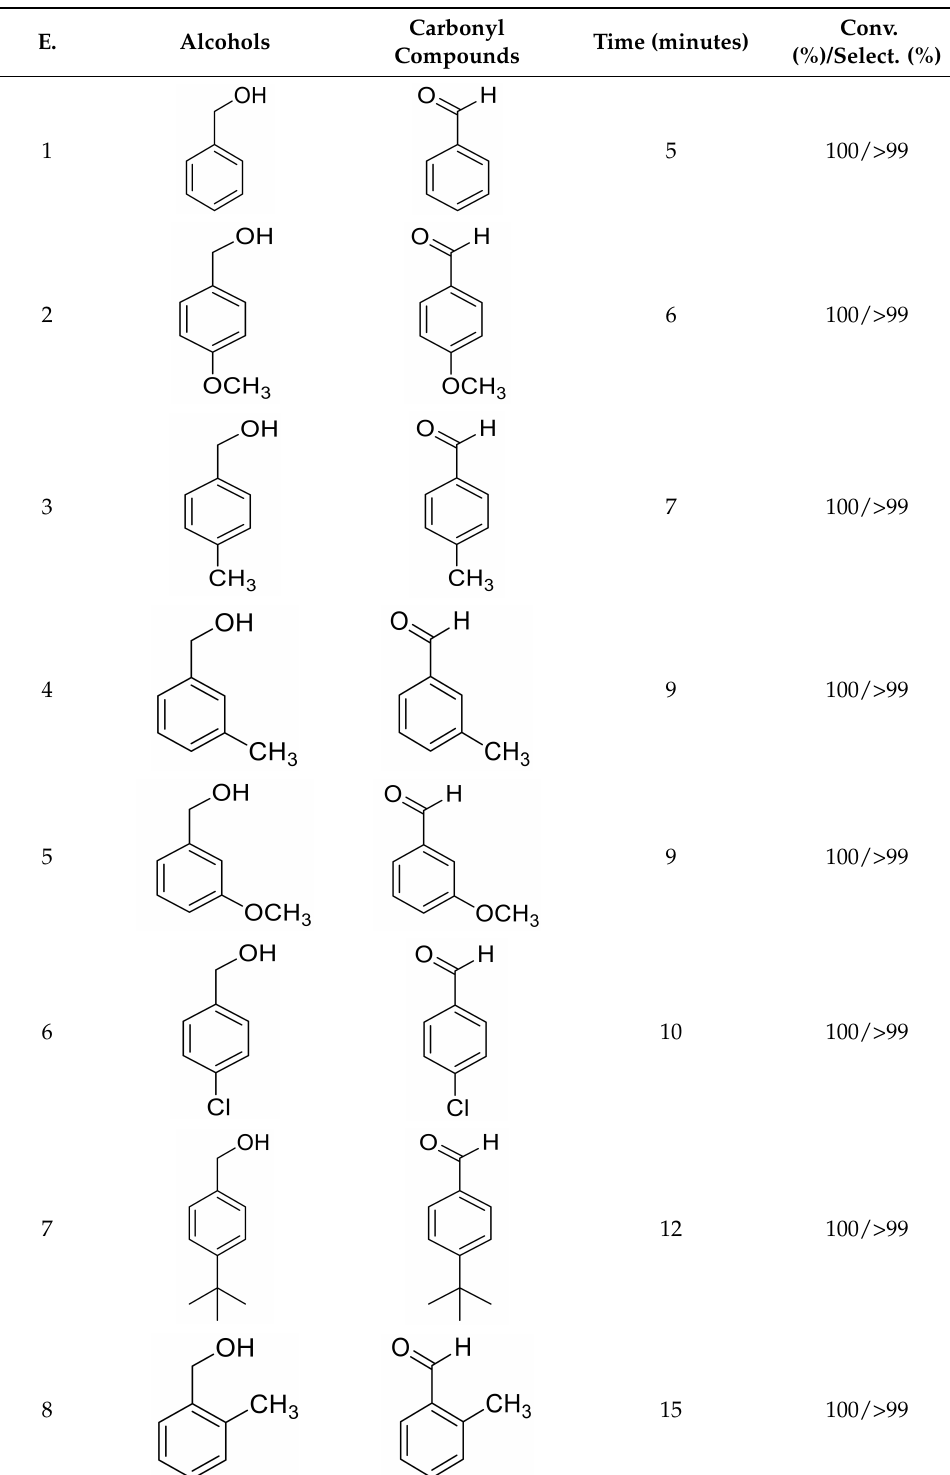
Table 4. Aerobic base-free dehydrogenation of various alcohols over (1%) ZnO–MnCO 3 /(1%-NDG) nanocomposite using gaseous O 2